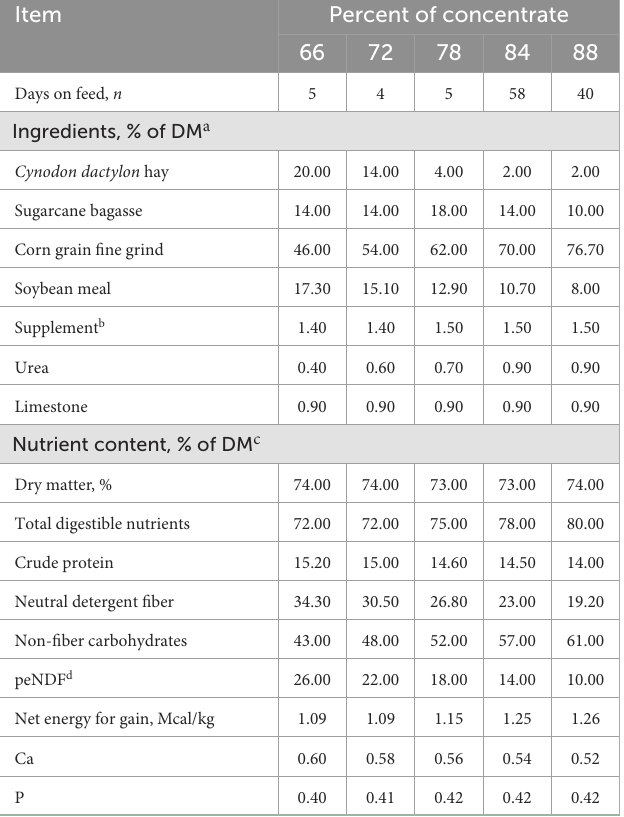
TABLE 1 Feed ingredients and chemical composition of high-concentrate diets fed to Nellore yearling bulls ( n = 30) during adaptation and finishing